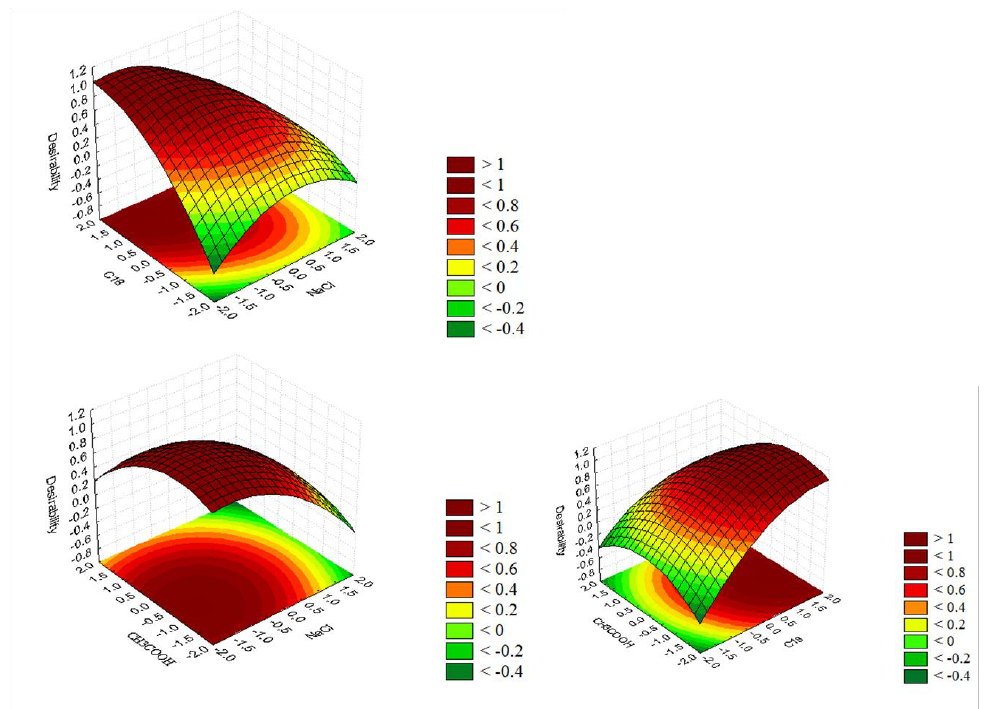
Figure 3. Response surface plots for the 2 3 central composite design (CCD).